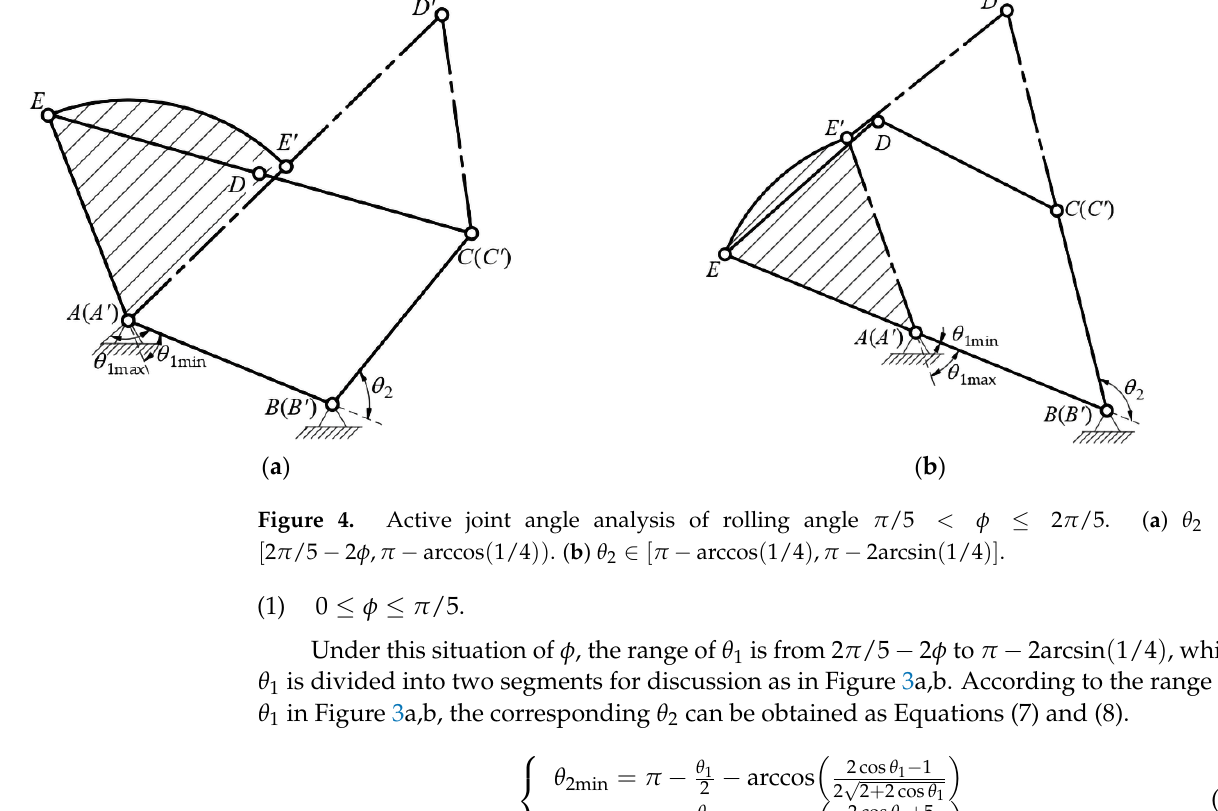
( b ) Figure 3. Active joint angle analysis of rolling angle 0 (cid:3409) 𝜙 (cid:3409) 𝜋 /5 . (a) 𝜃 (cid:2869) ∈ (cid:4670) 2 𝜋 /5 (cid:3398) 2 𝜙 , 𝜋 (cid:3398) arccos (cid:4666) 1/4 (cid:4667)(cid:4667) . (b) 𝜃 (cid:2869) ∈ (cid:4670)𝜋 (cid:3398) arccos (cid:4666) 1/4 (cid:4667) , 𝜋 (cid:3398) 2arcsin (cid:4666) 1/4 (cid:4667)(cid:4671) . (2) 𝜋 /5 (cid:3407) 𝜙 (cid:3409) 2 𝜋 /5 . Under this premise, the range of 𝜃 (cid:2870) is from 2 𝜋 /5 (cid:3398) 2 𝜙 to 𝜋 (cid:3398) 2arcsin (cid:4666) 1/4 (cid:4667) , and 𝜃 (cid:2870) is divided into two segments for discussion as in Figure 4a,b. According to the range of 𝜃 (cid:2870) in Figure 4a,b, the corresponding 𝜃 (cid:2869) can be obtained as Equations (9) and (10). ⎩⎪⎨⎪⎧𝜃 (cid:2869)(cid:2923)(cid:2919)(cid:2924) (cid:3404) 𝜋 (cid:3398) 𝜃 (cid:2870) 2 (cid:3398) arccos (cid:4678) 2cos 𝜃 (cid:2870) (cid:3398) 1 2 (cid:3493) 2 (cid:3397) 2cos 𝜃 (cid:2870) (cid:4679) 𝜃 (cid:2869)(cid:2923)(cid:2911)(cid:2934) (cid:3404) 𝜋 (cid:3398) 𝜃 (cid:2870) 2 (cid:3398) arccos (cid:4678) 2cos 𝜃 (cid:2870) (cid:3397) 5 2 (cid:3493) 2 (cid:3397) 2cos 𝜃 (cid:2870) (cid:4679)